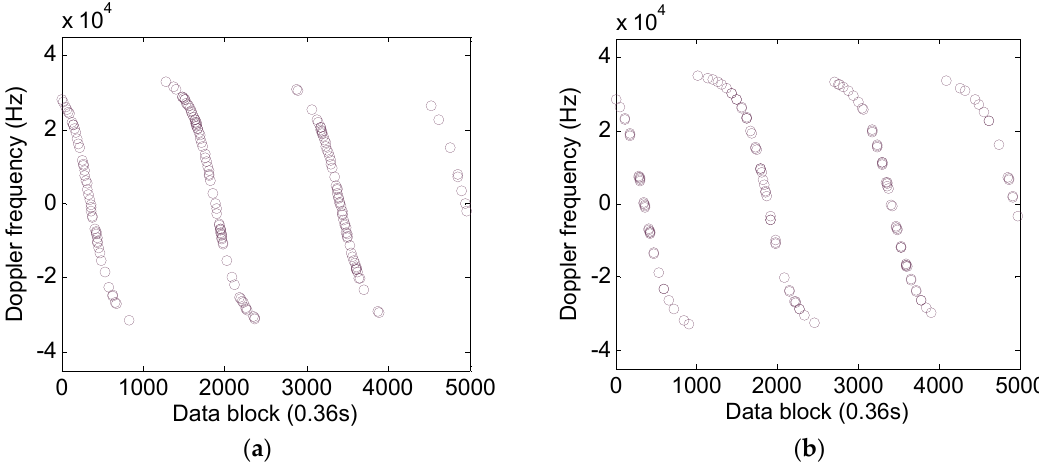
Figure 9. Doppler-shift estimation results of the IRIDIUM NEXT signals obtained by the new method: ( a ) Iridium ring alert signal Doppler-shift estimation results; ( b ) Iridium primary message signal Doppler-shift estimation results.